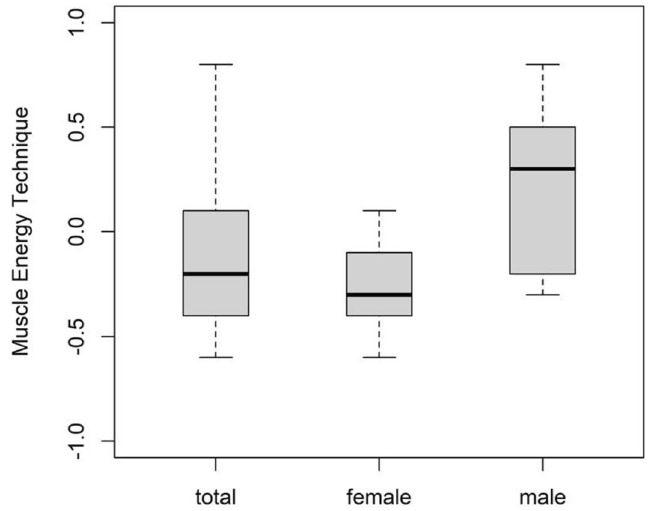
Figure 4. Mean differences in frequency of UT for MET; Legend: Not applicable.